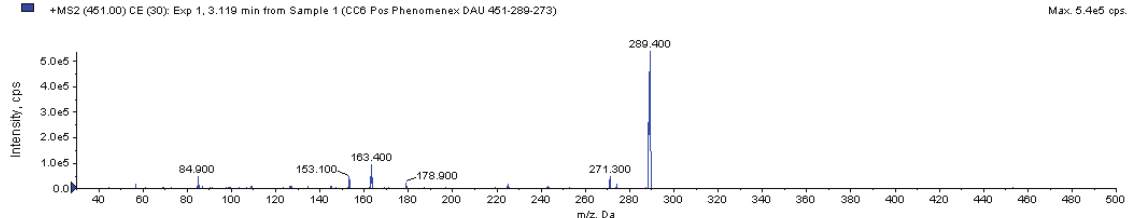
Figure 5. Mass spectrum of the compound with t